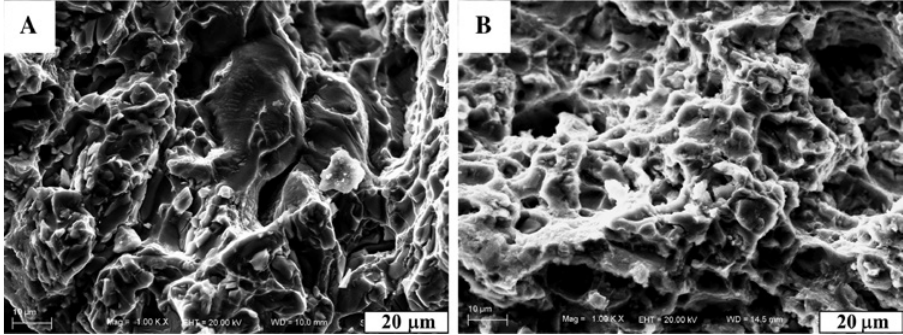
Figure 6: SEM fracture surfaces of the 4 vol.% SiC